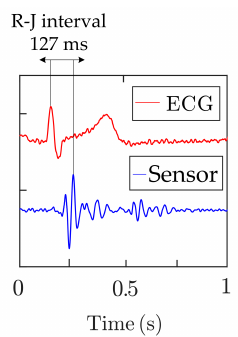
Figure 18. Example of analyzed R–J